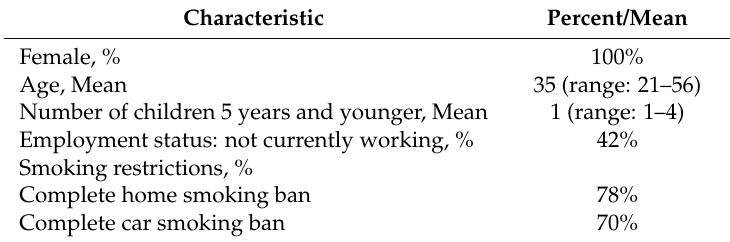
Table 3. Demographic characteristics of “Set the Rules” workshop